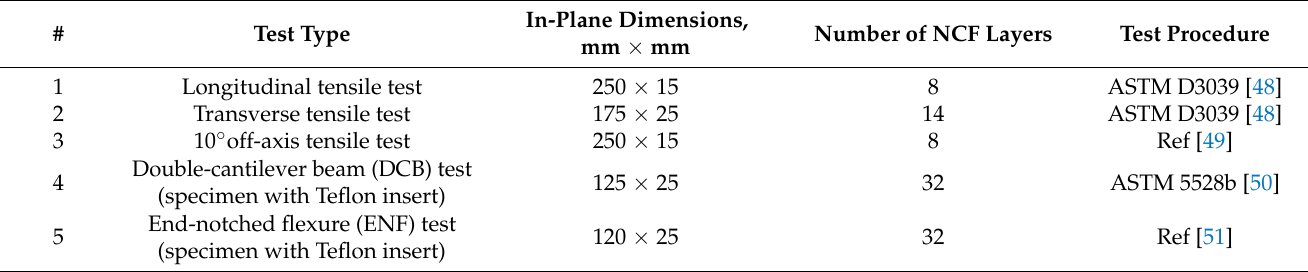
Table 1. Parameters of the processed tests specimens for NCF mechanical